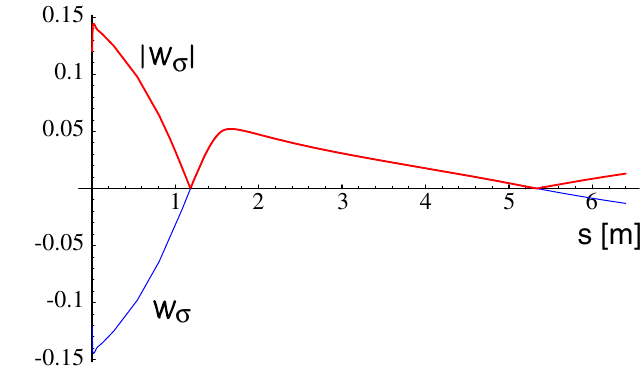
5.FIG. 7. (Color) W compensation requires W 1.5